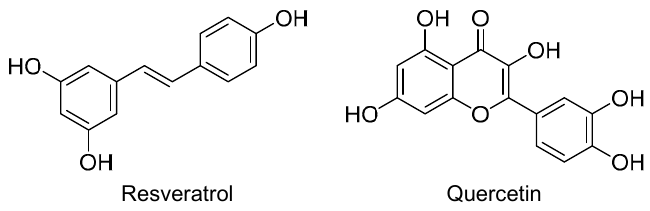
Figure9. Chemicalstructuresoftwonaturallyoccurringpolyphenols, i.e., resveratrolandquercetinwith Figure 9. Chemical structures of two naturally occurring polyphenols, i.e., resveratrol and quercetin a host of beneficial biological e ff ects including antiviral, anti-inflammatory, and antioxidant with a host of beneficial biological effects including antiviral, anti-inflammatory, and antioxidant activities.